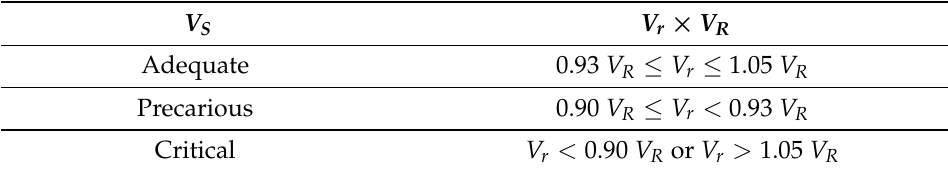
Table 2. Nominal voltage limits greater than 1 kV and less than 69 kV.